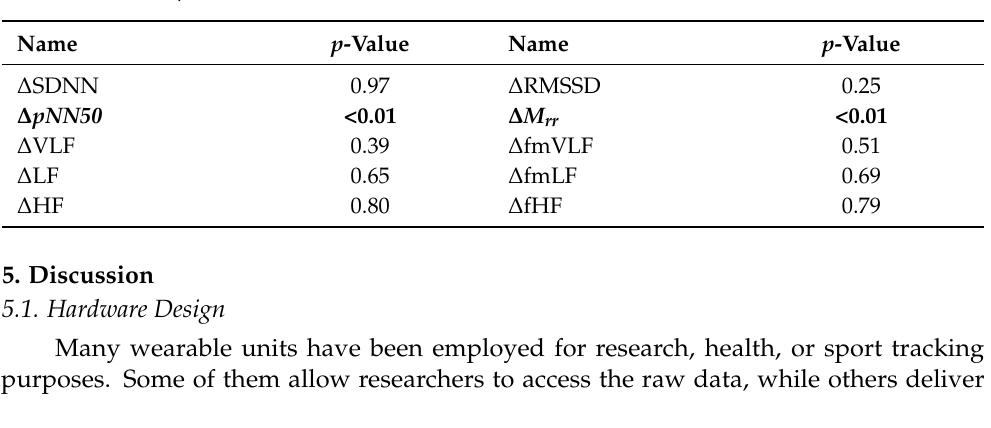
Table 7. ANOVA p -values for each ECG